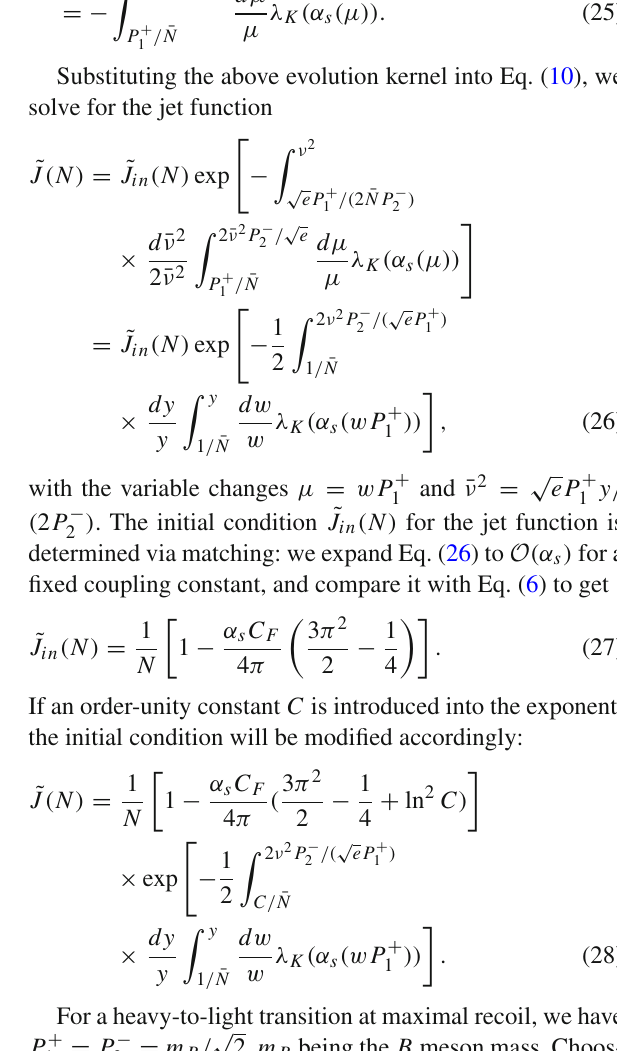
Fig. 3 O (α s ) hard function